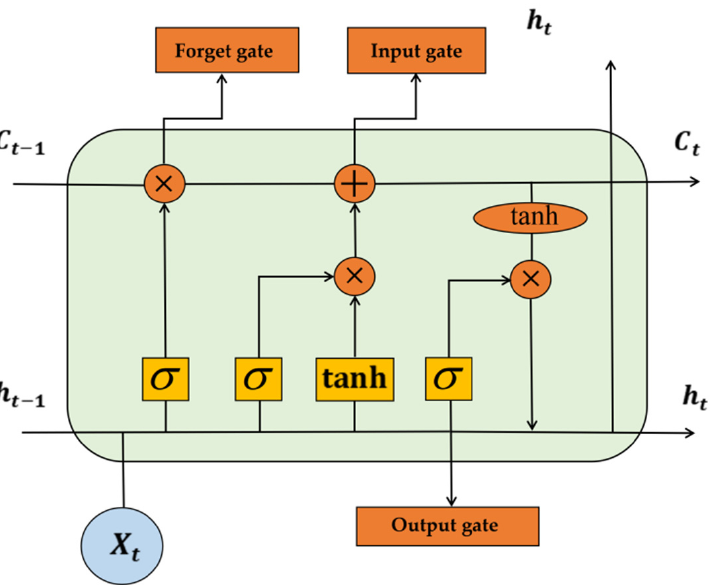
Figure 2. Long short-term cell structure. The blue circle at the bottom is the input data of a cell of the LSTM. The orange rectangular part is the forget gate, input gate and output gate. The yellow part is the calculation formula for generating forget gate, input gate and output gate. The orange circular part is the operator for generating forget gate, input gate and output gate.